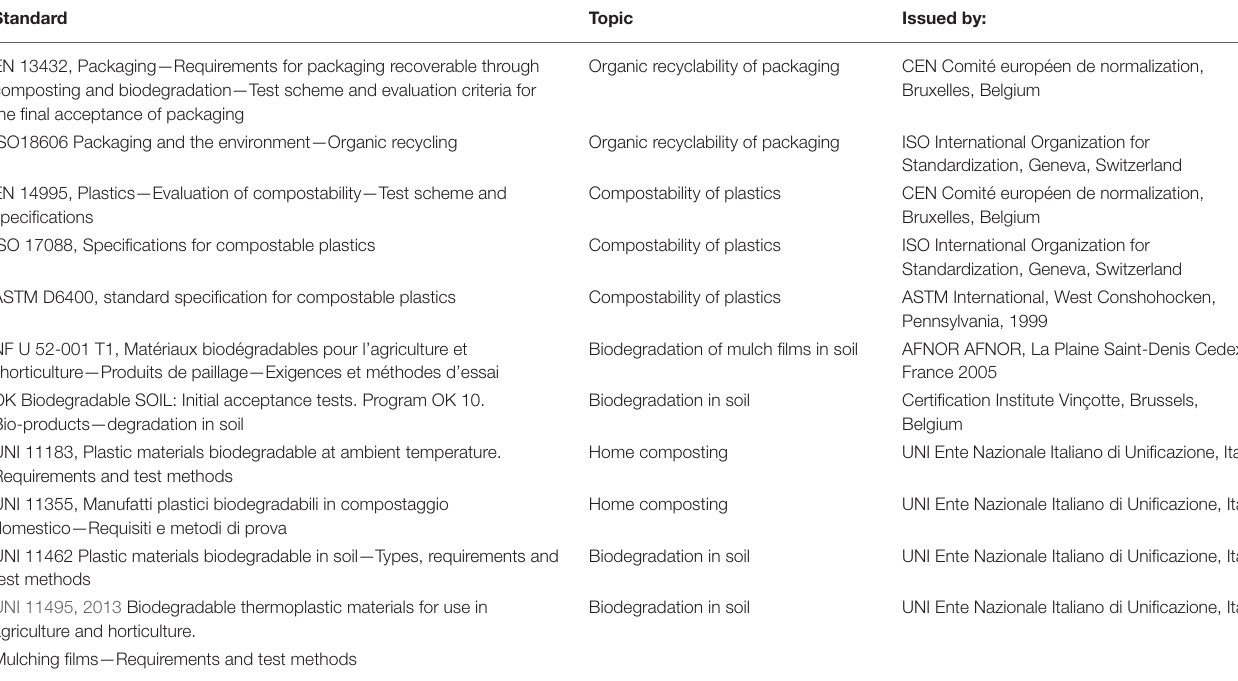
TABLE 1 | Main standards on plastics and packaging that are biodegradable in different conditions. Standard Topic Issued